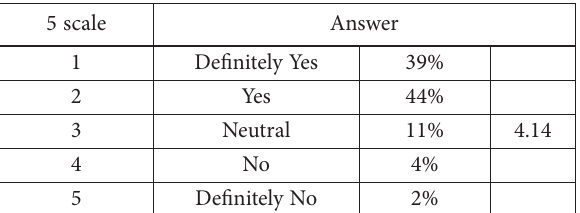
Table 2. Understanding the Likert scale (Zahid,